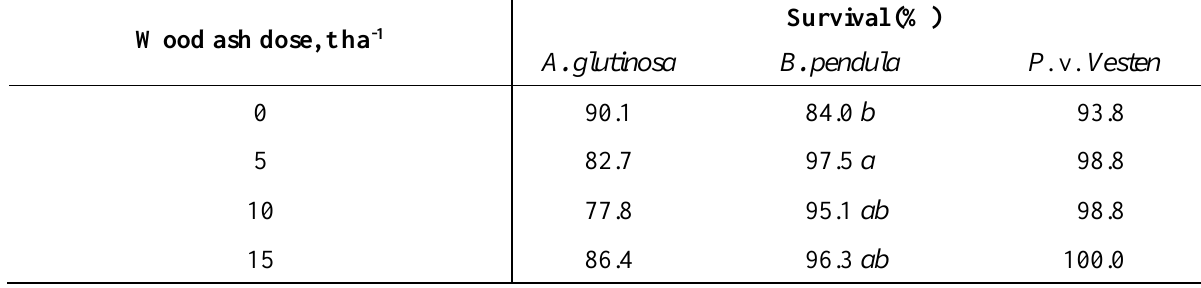
Table 1. Mean survival of multiple tree species in cutaway peatland fertilised with different doses of wood ash. Letters denote significant (p adj . < 0.05) difference between fertiliser dose for each species.